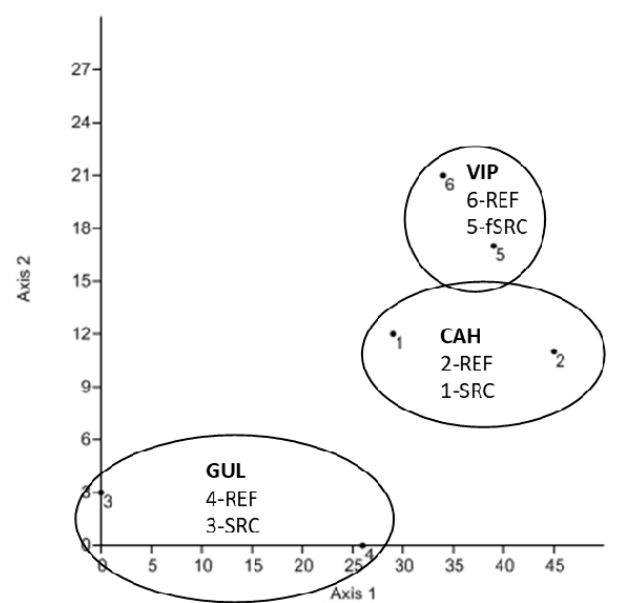
Figure 5. Multivariate detrended correspondence analysis (DCA) based on the relative abundances of substance classes in the soil organic matter (Py-FIMS) and the abundance of PLFA marker signals in the soil. Circles represent separate test sites with two managements: under short rotation coppice (SRC) or former short rotation coppice (fSRC) and reference sites with cereals or grassland (REF) (each point is based on three replicates per treatment).